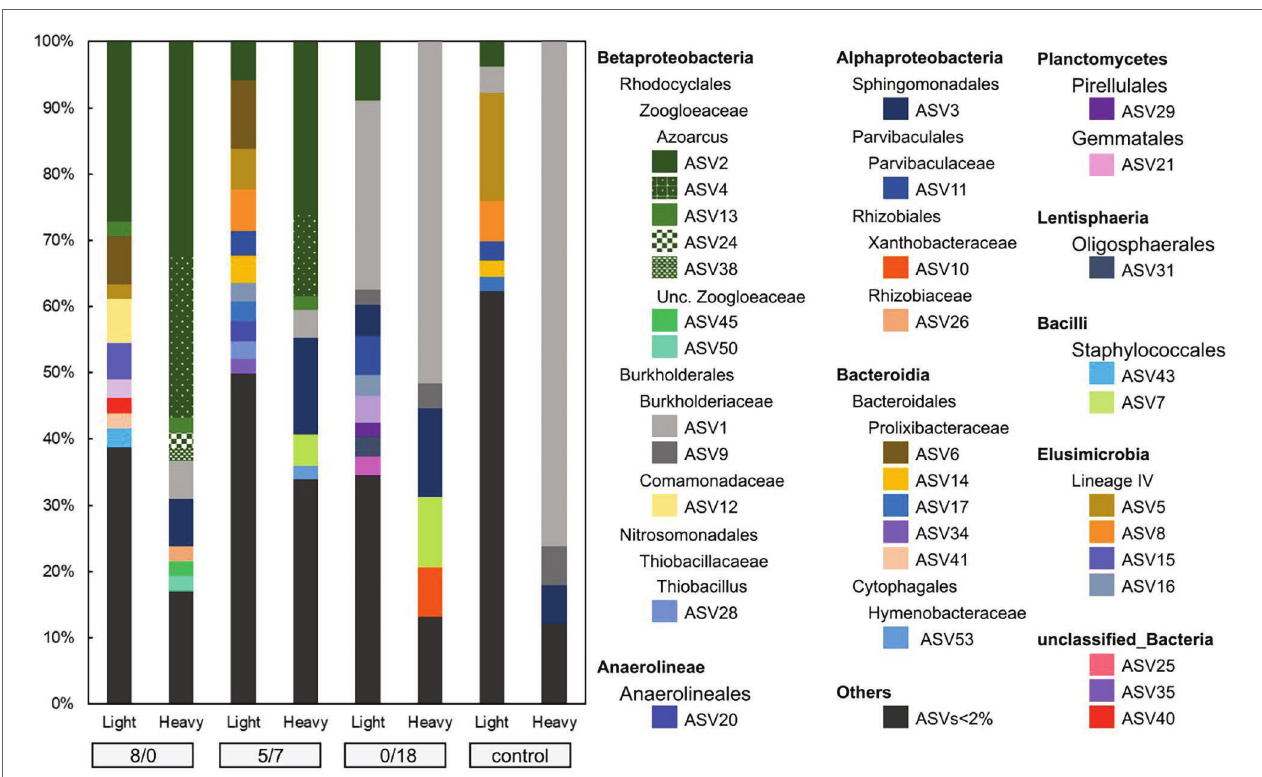
FIGURE 3 | ASVs (amplicon sequencing variants) diversity in light and heavy fractions of the 8/0 , 5/7 , 0/18 , and the control microcosms. ASVs with relative abundance <2% were not individually